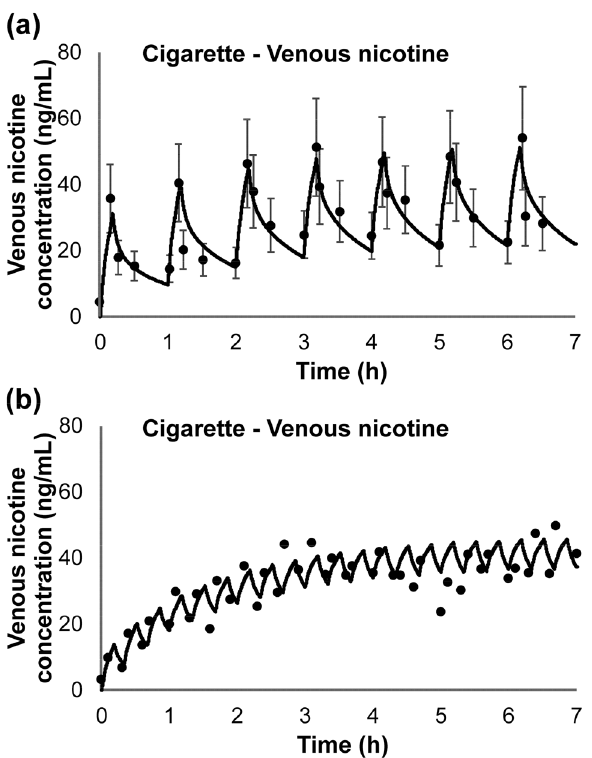
Figure 15. Simulation of the time-course kinetic data during and after repeated use of a conventional cigarette 31 . The subjects used ( a ) 1 cigarette/h over 7 h or ( b ) 3 cigarettes/h over 7 h. Points represent data from the study and solid lines represent simulation